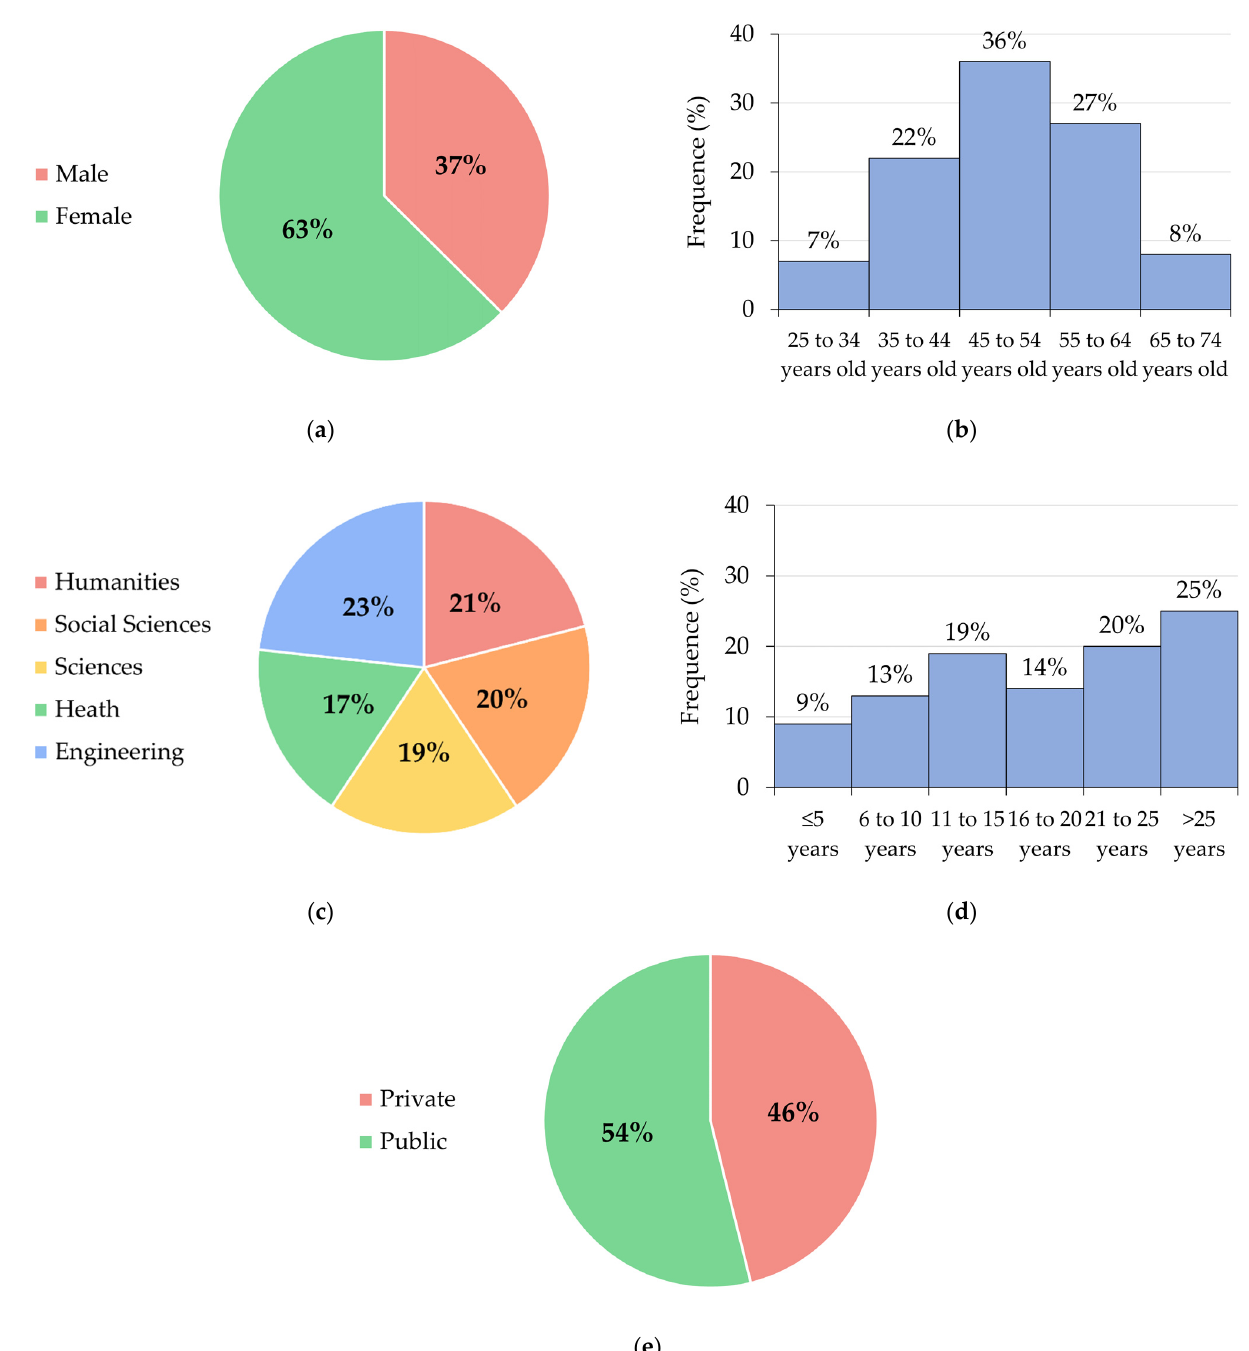
Figure 2 . Distributions of the sample participants differentiated according to the different values of the independent variables considered: ( a ) gender; ( b ) age range; ( c ) area of knowledge; ( d ) years of teaching experience; ( e ) university tenure.